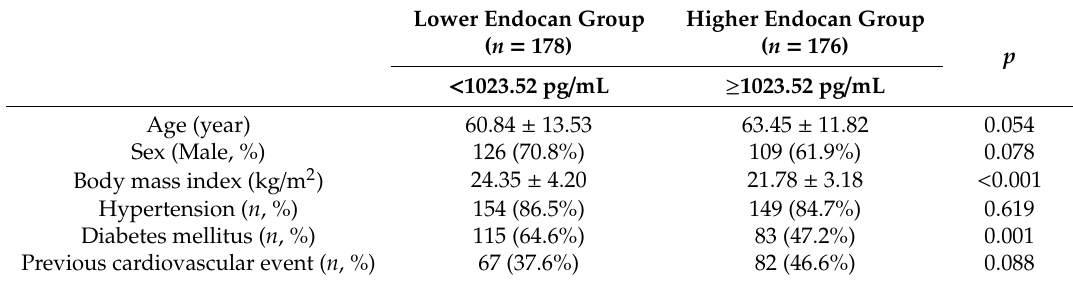
Table 1. Baseline characteristics according to plasma endocan